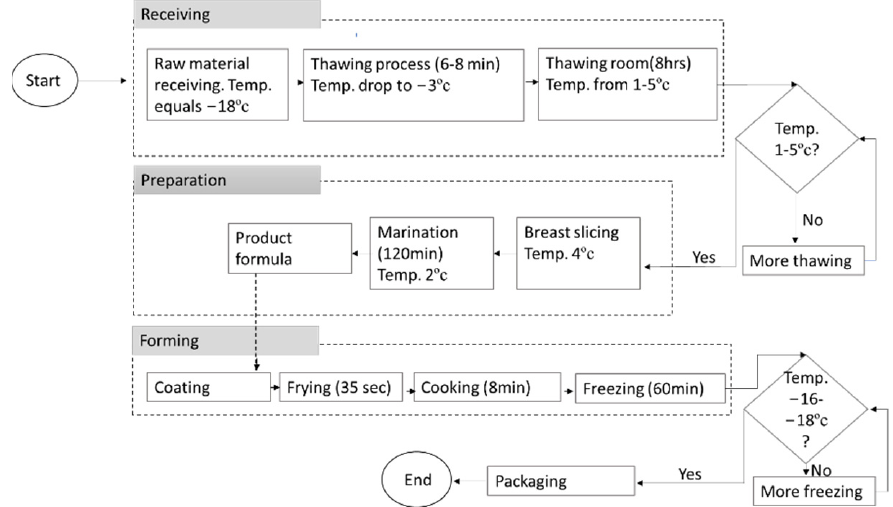
Figure 2. Flowchart of all the processes in the studied production line.